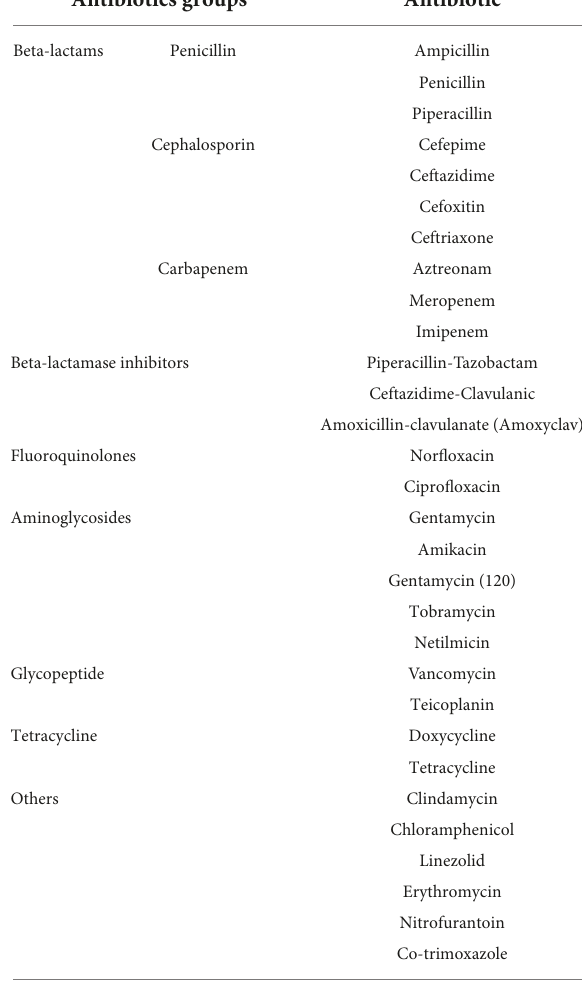
TABLE 1 Antibiotics used against different isolated